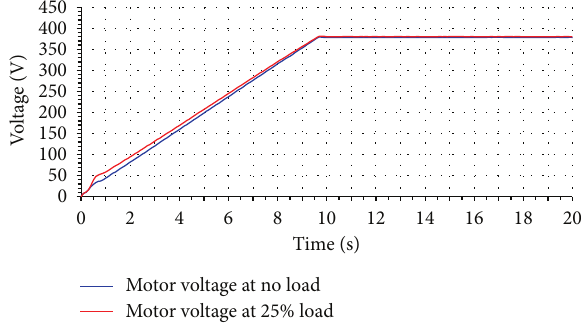
Figure 6: Voltage variation of IM drive during starting at different loads and 1440rpm